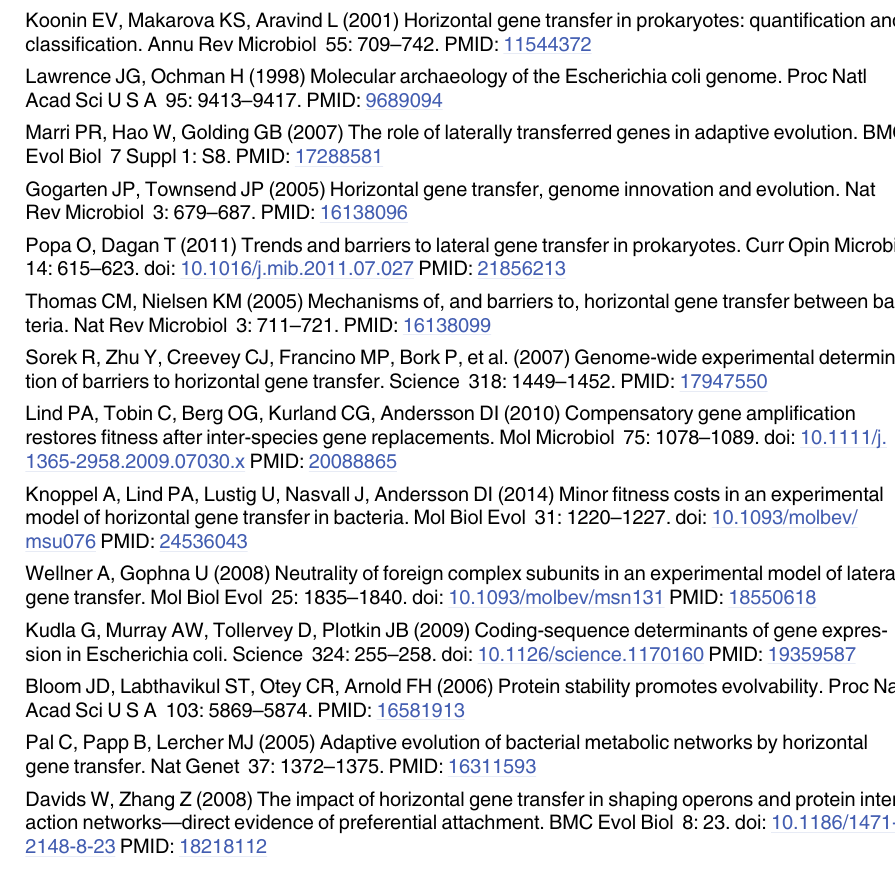
S3 Table. Intracellular abundance, folA promoter activity and growth rates of the HGT strains. S4 Table. Whole-genome sequencing. S5 Table. Validation of whole-genome sequencing results by direct PCR. S6 Table. Global proteome quantification by TMT LC-MS/MS. (A) Relative abundance (B) log10 of relative abundance (C) z-scores of log10 of relative